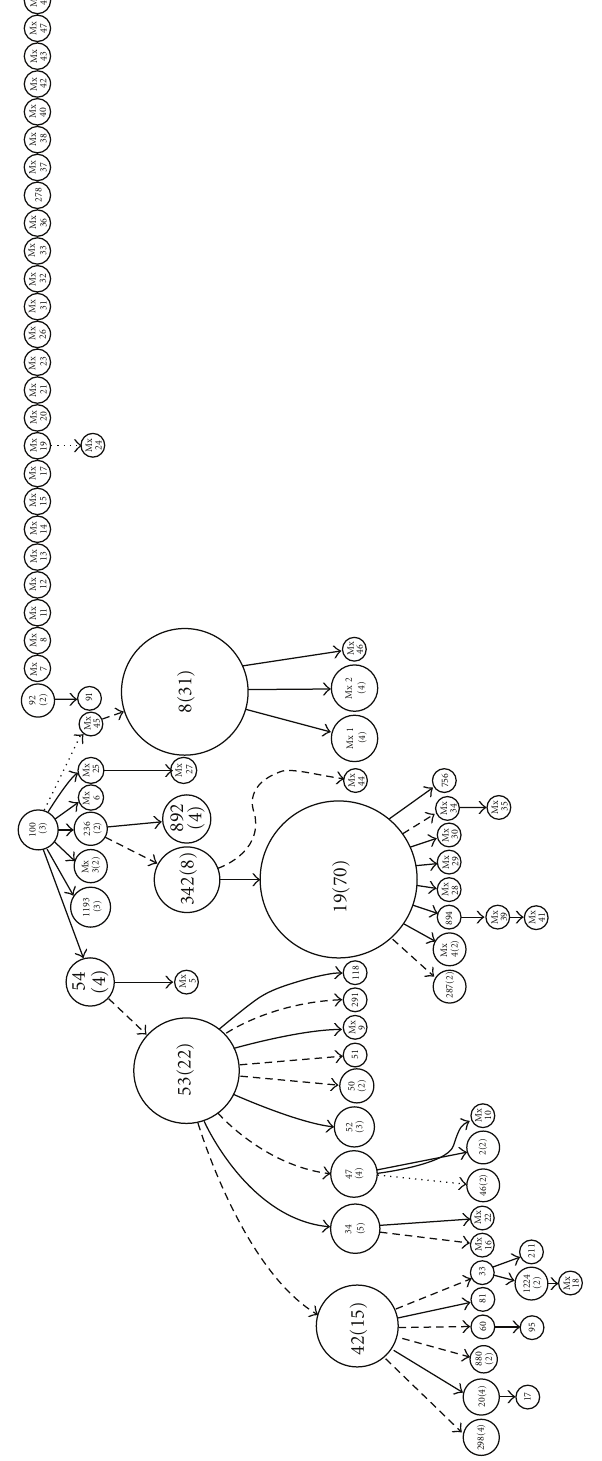
Figure 1: Spoligoforest of tuberculosis cases in Acapulco, Mexico. Nodes are labeled with the ST identifier as indicated in SoplDB4 [3], with the cluster size enclosed in parentheses. Spoligotype not in SpolDB4 was labeled as “Mx” with a number. The size of each node increases as a function of the number of isolates (size of the cluster); the lines among the nodes reflect the evolutionary relationships among spoligotypes with arrows that denote the descendent. If the weight of the line was equal to 1, we drew a solid line; if the weight was greater than or equal to 0.5 but less than 1, we used a dashed line; if the weight was less than 0.5, we used a dotted